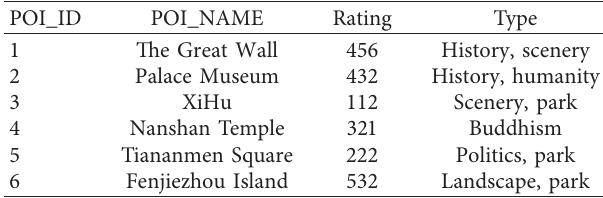
Table 1: Types of attractions.